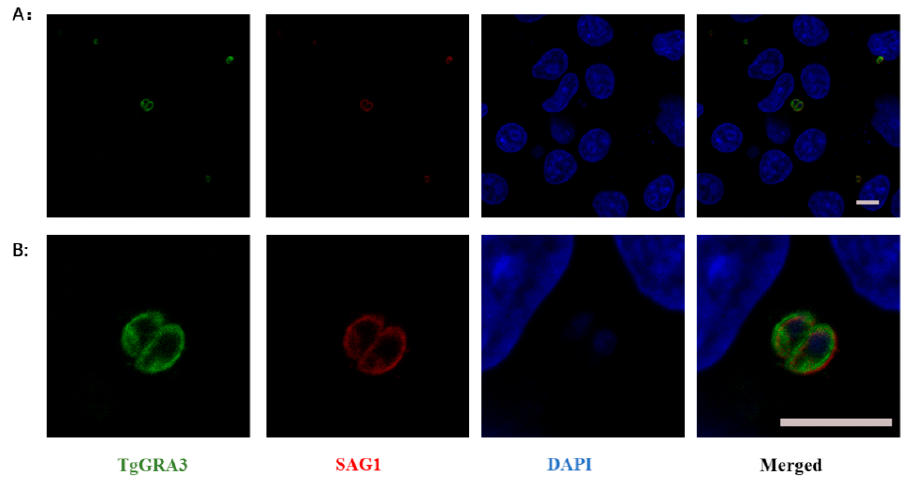
Figure 5. Confocal laser scanning microscopy of the T.gondii antigen recognized by GRA3 PcAb. Vero cells were infected with T. gondii ME49 strain tachyzoite for 24 h and parasites were detected by GRA3 PcAb. T. gondii was triple-stained with the GRA3 PcAb (green), SAG1 (red), and DAPI (blue). Scale bar = 10 µ m. Group ( A ) is the full view. Group ( B ) is corresponding partial enlargement.